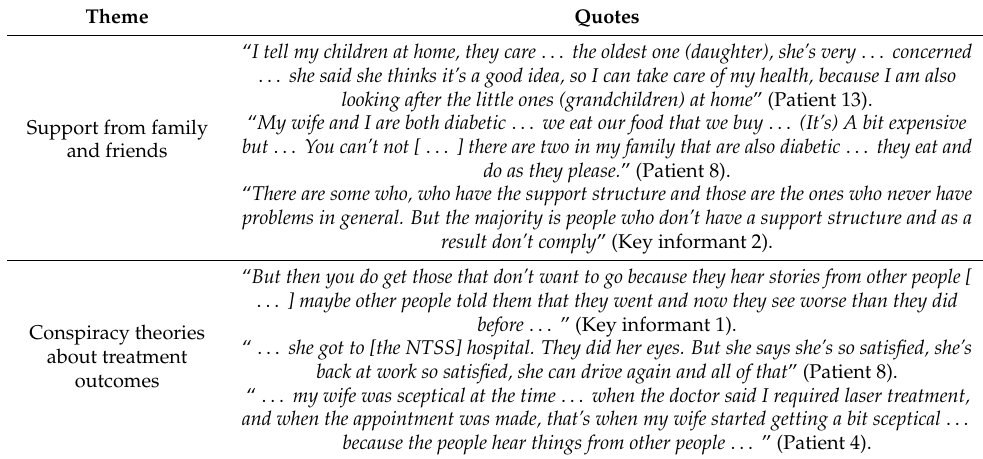
Table 4. Community factors.